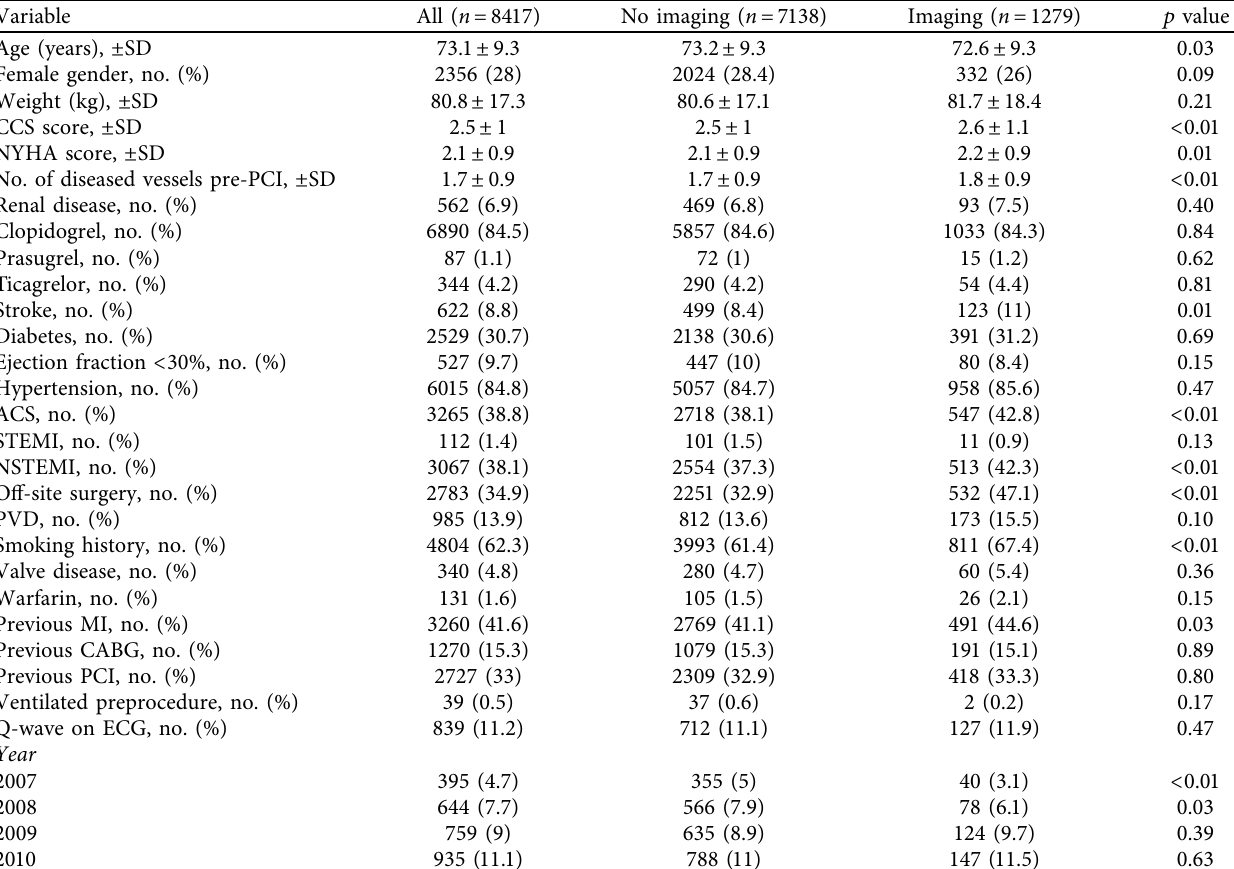
Figure 1: Trends in intravascular imaging use in RA-PCI performed in England and Wales, 2007–2014. (a) Crude numbers of imaging (dark grey bars) and nonimaging RA-PCI cases (light grey bars); (b) percentage of RA-PCI cases utilising imaging as a proportion of all RA-PCI demonstrates an initial rise followed by a plateau ( p for trend < 0.001). Table 1: Baseline participant characteristics by intracoronary imaging use in patients undergoing RA-PCI in England and Wales, 2007 −